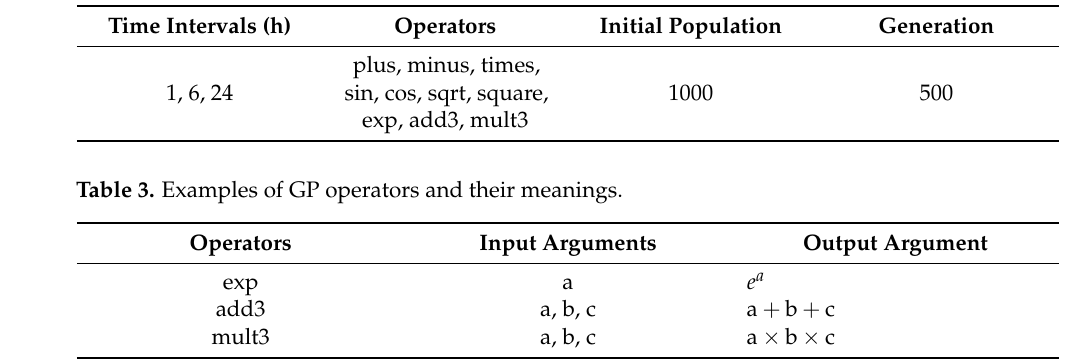
Table 2. The parameter settings of the proposed GP.